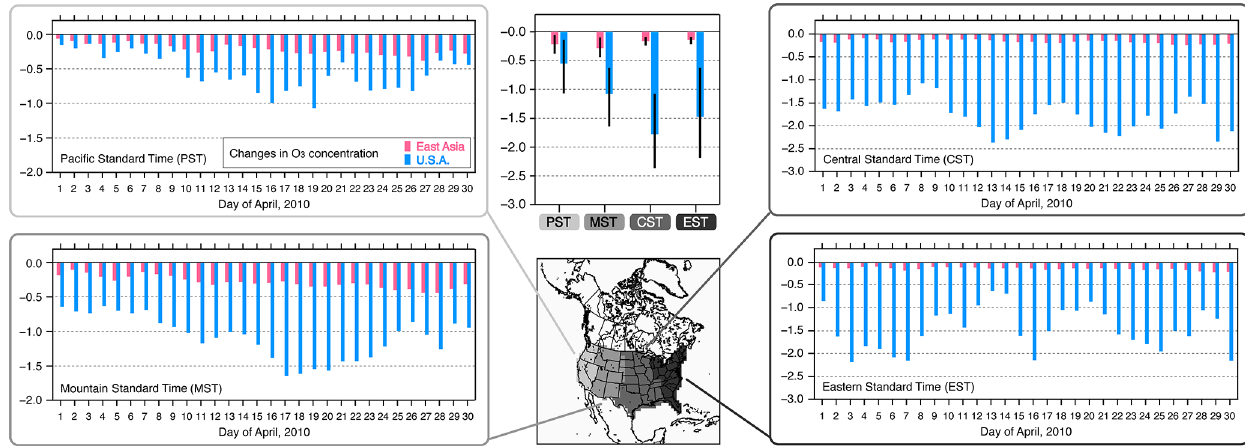
Figure 10. Perspective of daily and monthly averaged changes in O 3 mixing ratio resulting from estimated 2010–2015 emission changes over the US (light blue bars) and east Asia (light red bars) summarized over four time zones of Pacific, Mountain, Central, and Eastern Standard Time (PST, MST, CST, and EST) in the US. The units are ppbv. On a monthly average (center panel), whiskers indicate daily minimum and maximum. Note that the axis is different in the left (PST and MST) and right panels (CST and